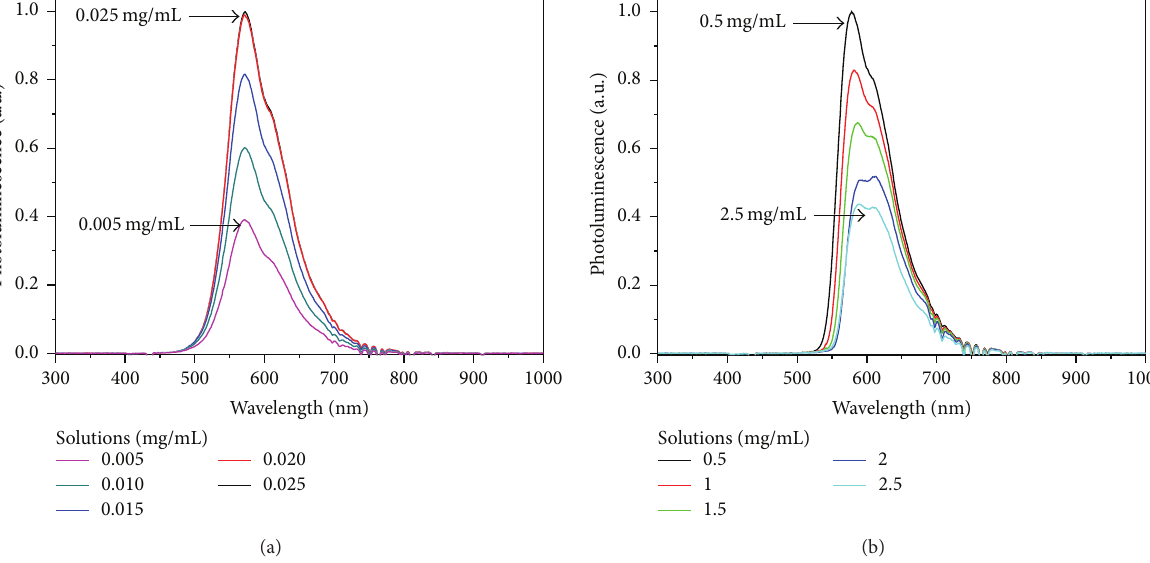
interchain transitions in the stacked thiophene rings, which result in the lowered energy excited states